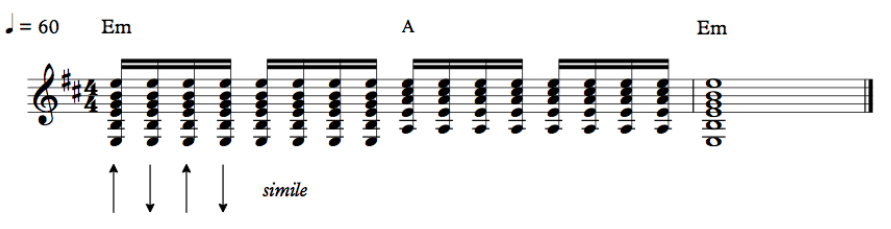
Figure 8. Musical excerpt 1.